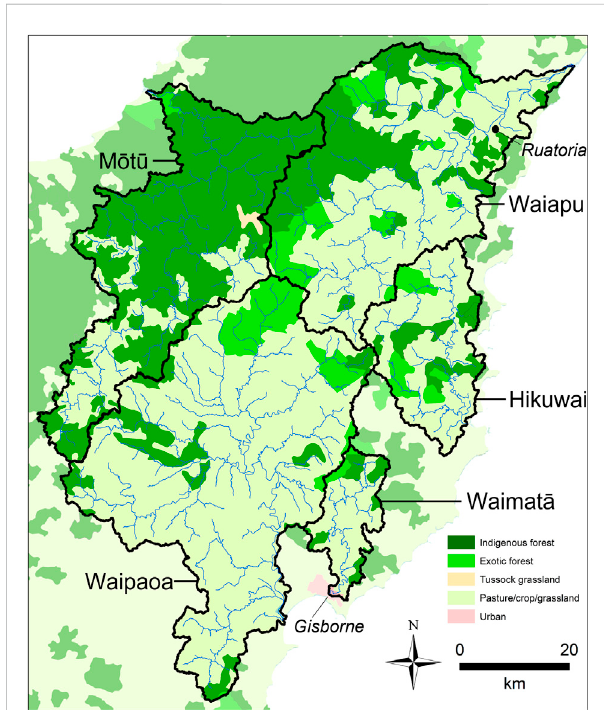
FIGURE 4 Contemporary vegetation cover and land use across Tair ā whiti catchments. The region has been subjected to near-systematic deforestation, with remnants of indigenous forest in northern and western headwater tributaries of the Waiapu and the lower course of the M ō t ū . Urban development in the region is restricted to Gisborne